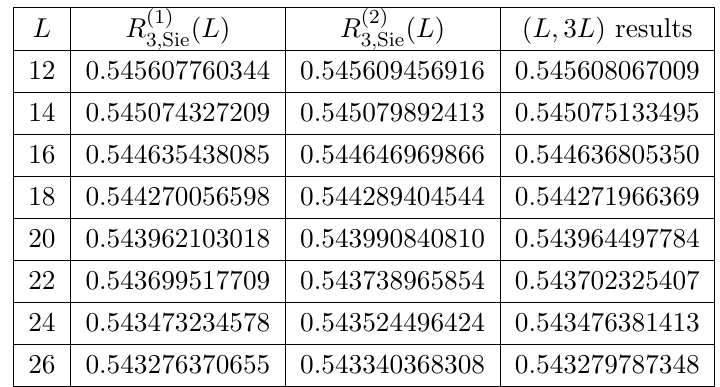
Table 13 . The rational functions R (1) truncation computations in Siegel